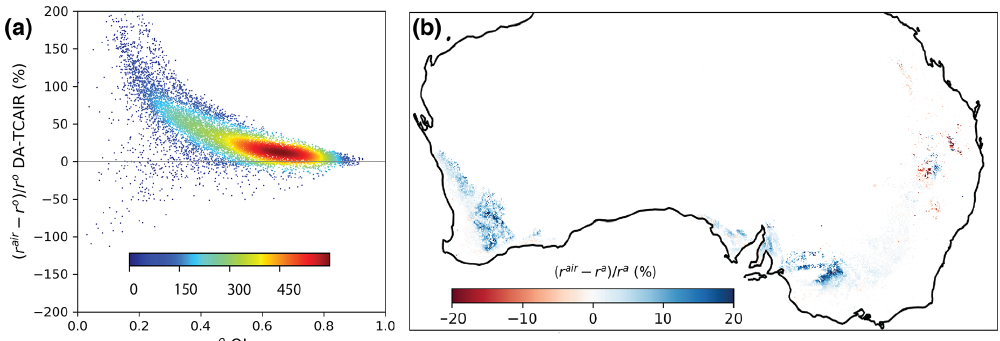
Figure 9. Comparison of vegetation index, EVI, with modelled root-zone soil moisture over cropland: (a) changes in correlations after data assimilation (DA-TCAIR, r air ) compared to model OL ( r o ) and (b) changes in correlations between DA-TCAIR and DA-TC.